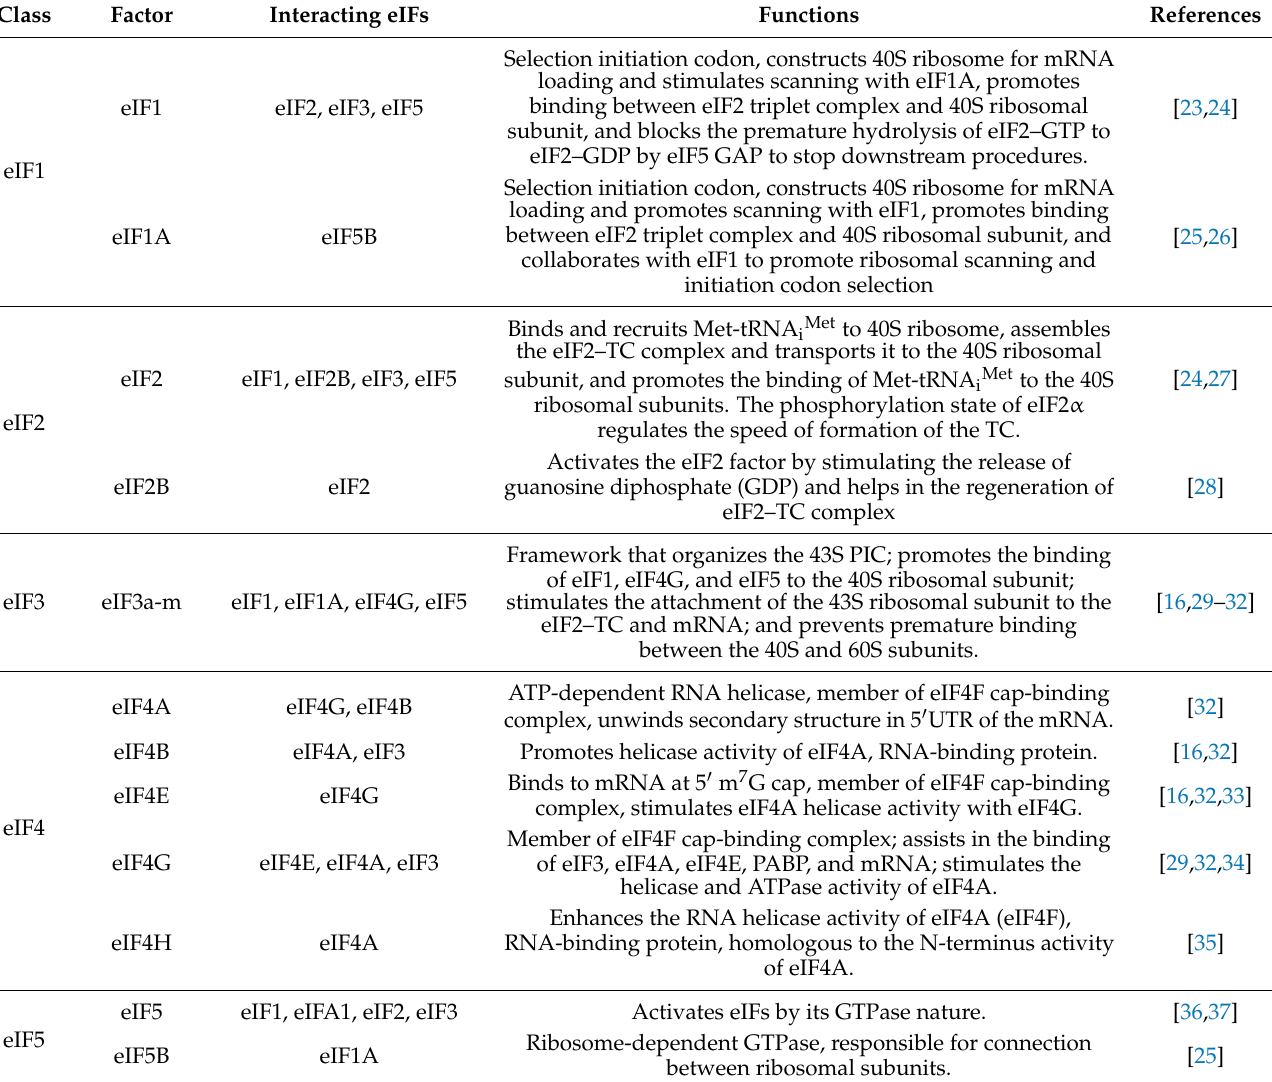
Table 1. Functions of eIFs and subunits in translation initiation. eIF—eukaryotic translation